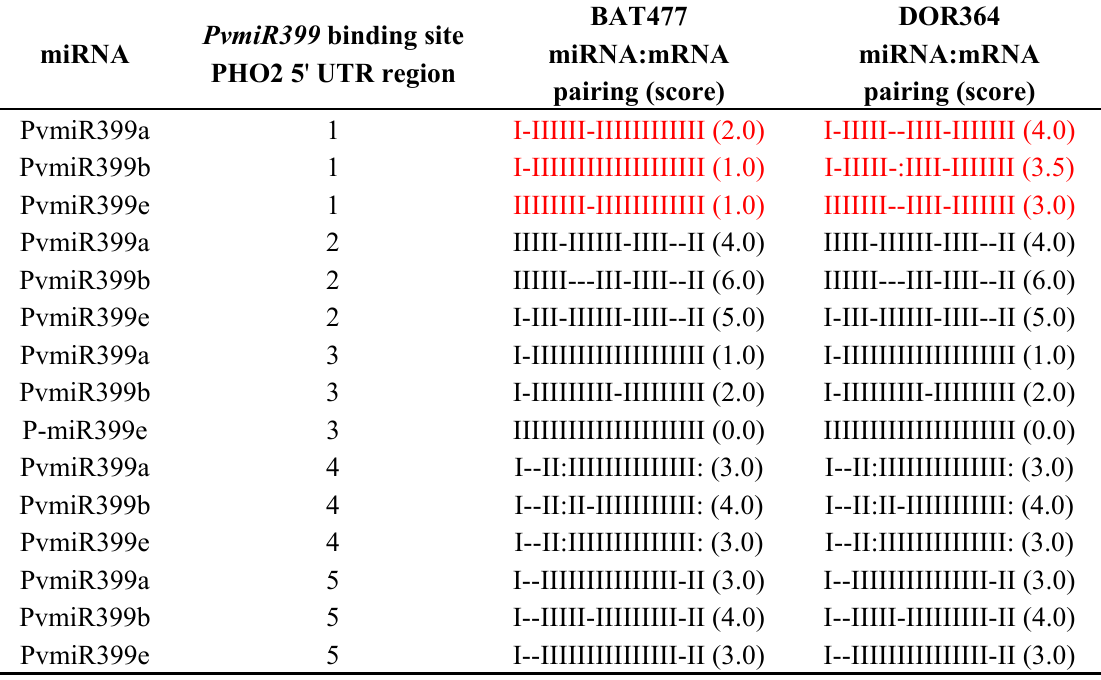
DOR364 genotypes (Table 1). The 30 miRNA:mRNA pairing scores obtained indicated that the five sites identified may be functional for PvmiR399 mediated PvPHO2 mRNA degradation, except site 2 with PvmiR399b, which showed a score of 6 (Table 1). The DNA sequence and scores observed for the 2, 3, 4 and 5 PvmiR399 predicted binding sites were identical between the two genotypes (Figure 3, different PvmiR399: PvPHO2 pairing scores when comparing BAT477 to DOR364 (Table 1). Table 1. Pairing of PvmiR399 isoforms a, b and e with the predicted binding sites of the 5' UTR of the PvPHO2 target gene from BAT477 and DOR364 genotypes. The sequence of the predicted binding sites is shown in Figure 3. Watson-Crick base pairing is indicated by “I”; G:U base pairing by “:”; and “-” indicates a mismatch. Each miRNA:mRNA alignment score is shown in parenthesis: mismatch penalty = 1, G:U pair penalty = 0.5 [25]. Differences between BAT477 and DOR364 in binding site 1 are highlighted in